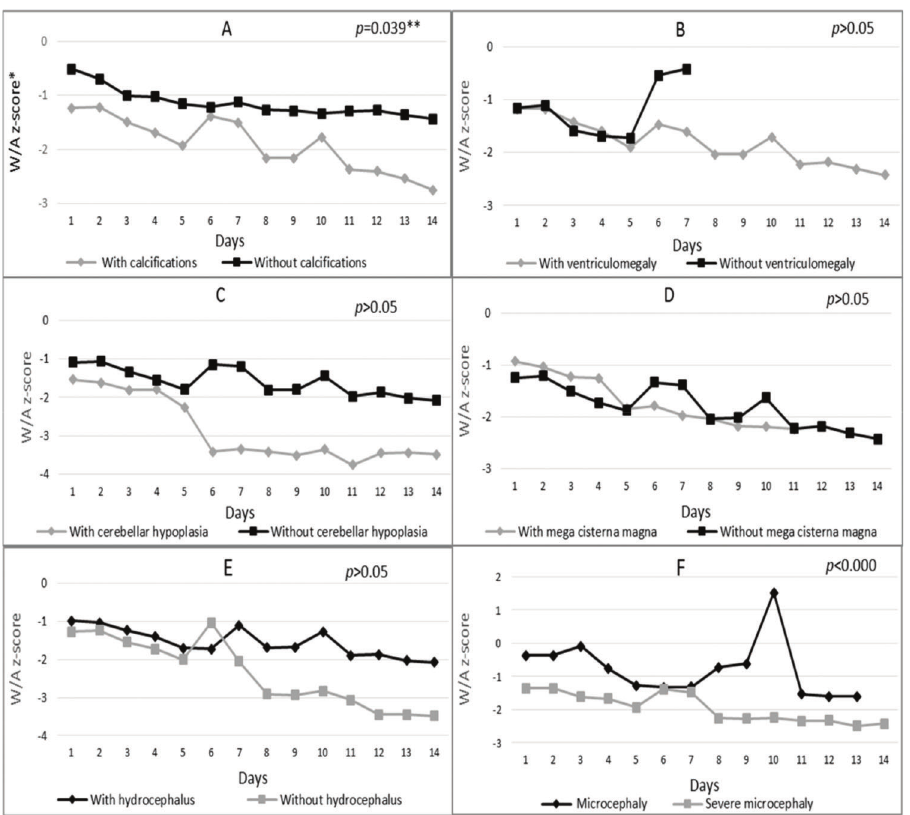
Figure 2 - Nutritional status variation (weight-for-age z-score) according to the presence or absence of A-Calcifications, B-Ventriculomegaly, C-Cerebellar hypoplasia, D-Mega cisterna magna and E-Hydrocephalus and F-Degree of microcephaly during the hospitalization of microcephalic newborns at IFF/FIOCRUZ, Rio de Janeiro, Brazil, 2016. *W/A: weight-for-age; **generalized estimating equation model; ***Broken lines in some charts are due to the lack of newborns in the category on the day of hospitalization.